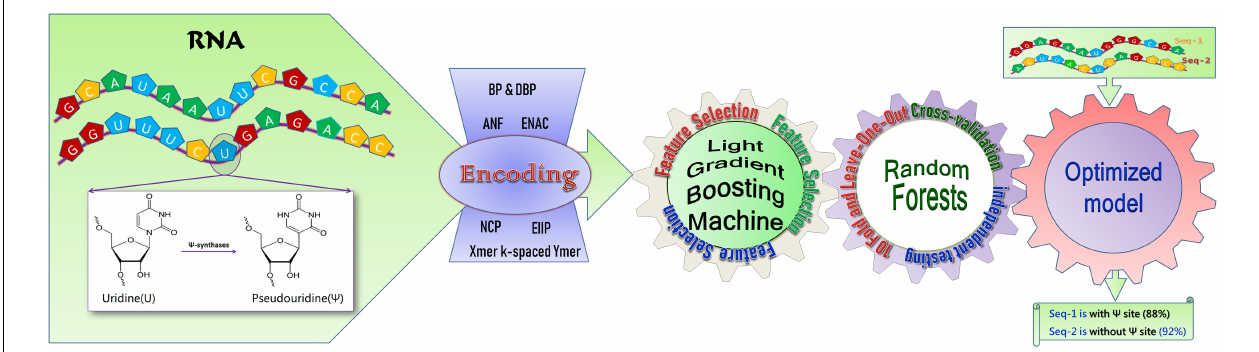
FIGURE 1 | A schematic diagram of RF-PseU. RNA sequences with or without pseudouridine sites were encoded via seven RNA coding technologies; following removal of redundant features by light gradient boosting machine feature selection, the random forest model was trained on smaller but more relevant feature vector spaces, and was evaluated through cross-validation and independent testing to obtain an optimized model for prediction.